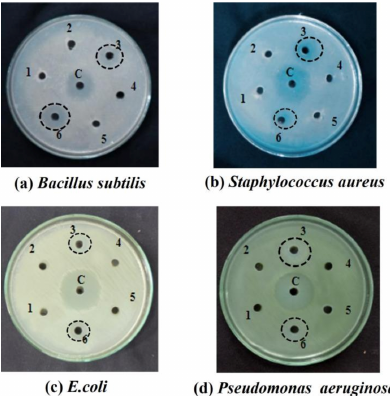
Figure 2. Antibacterial activity of isolated pure culture bacterial strain of buffalo milk (well no: 3) and cow milk (well no: 6) against ( a ) Bacillus subtilis; ( b ) Staphylococcus aureus; ( c ) Escherichia coli; ( d ) Pseudomonas aeruginosa